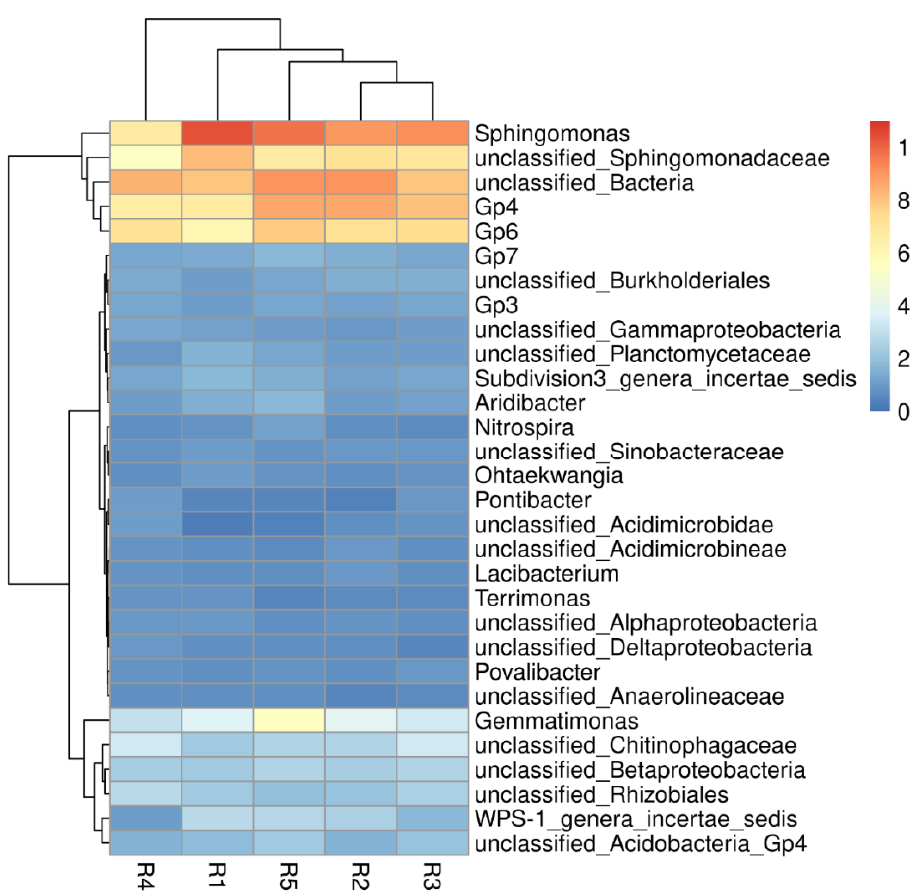
Figure 3. The relative abundance of bacterial community composition in classes level. R1, R2, R3,